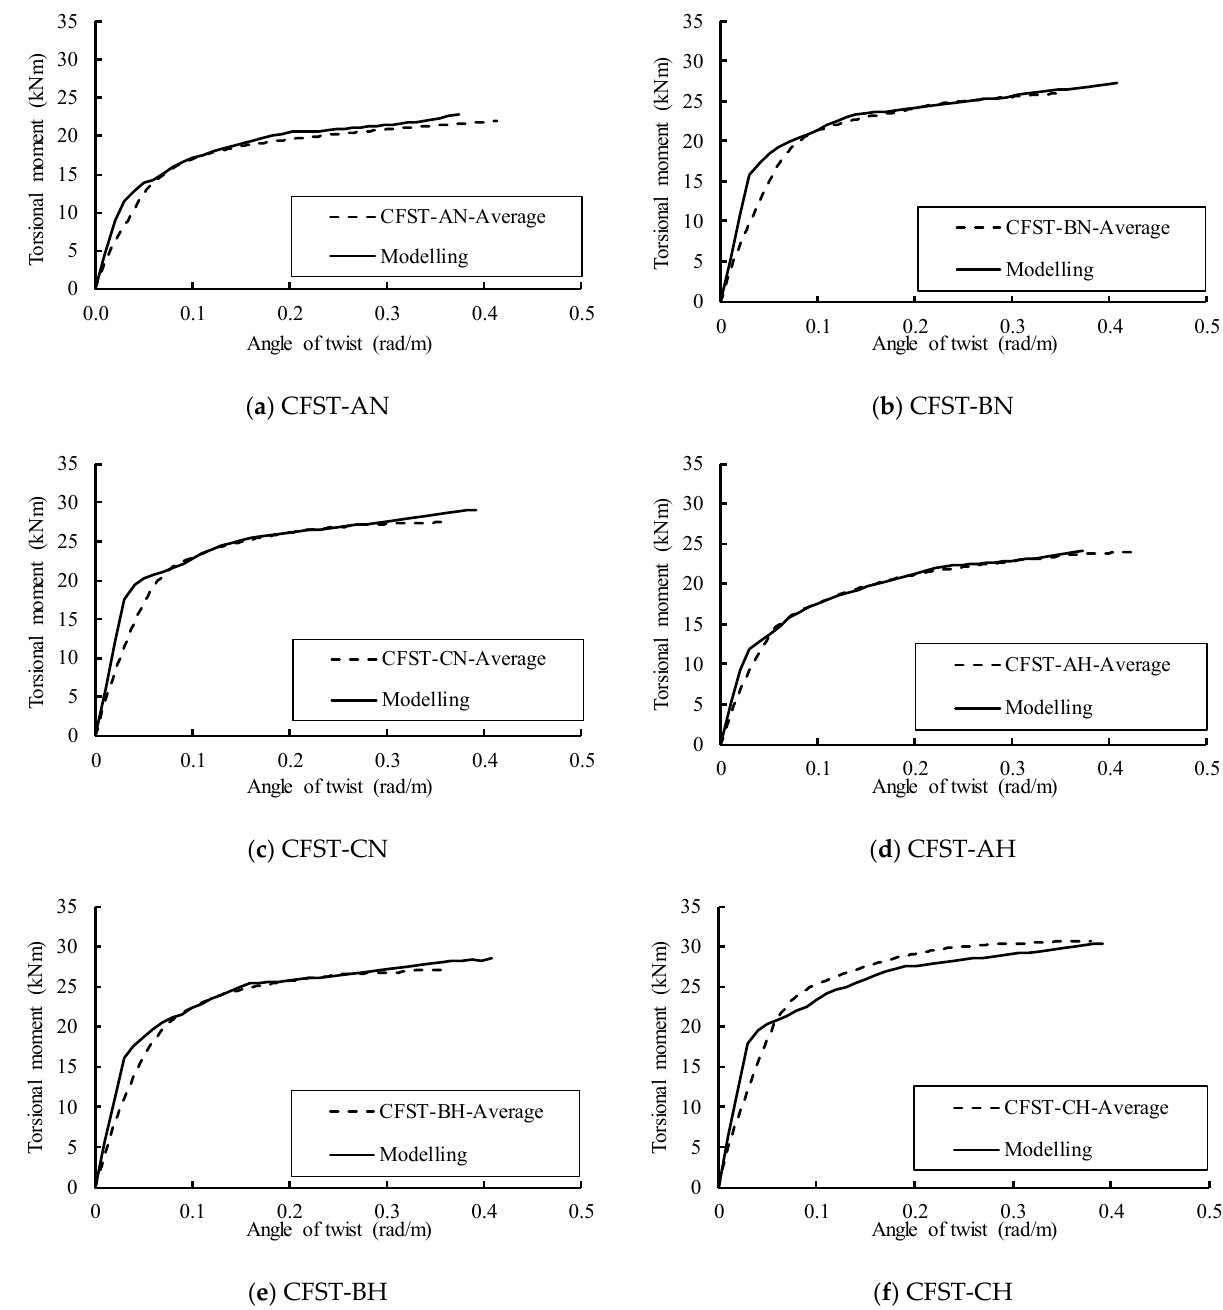
Figure 8. Comparing the numerical and experimental (adapted from [64]) results.